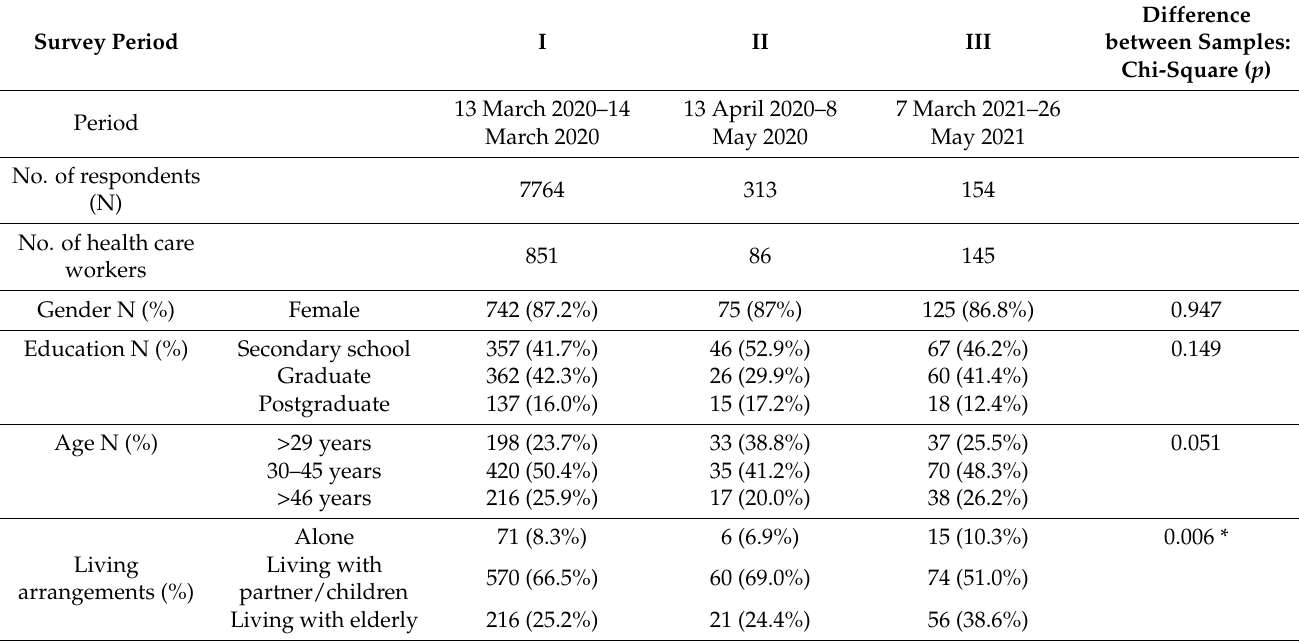
Table 1. Time frame of survey activity and demographic characteristics of